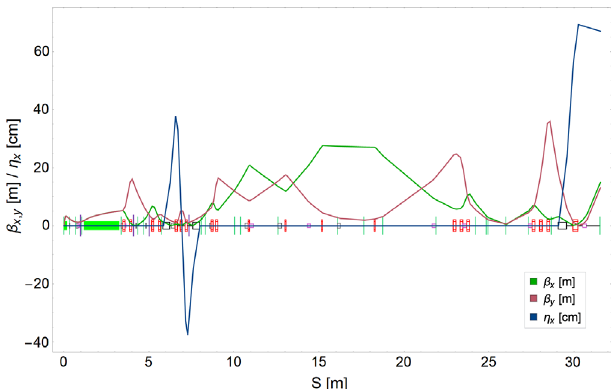
FIG. 5. Transverse Twiss parameters for the CLARA to BA1 beam line, showing the horizontal and vertical Beta function along with the horizontal dispersion. The BA1 interaction point is at ≈ 26 m in this plot.